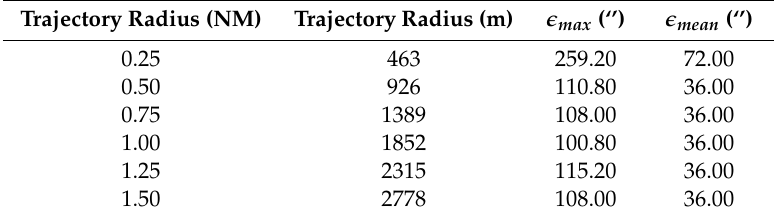
Table 6. Misalignment error as a function of the trajectory radius.